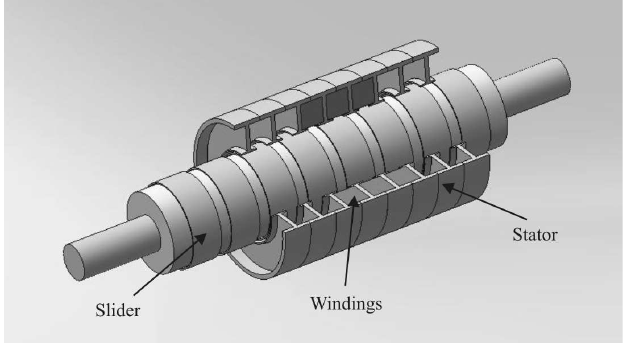
Figure 5. Schematic of three-phase TPM-LiG with a modular stator